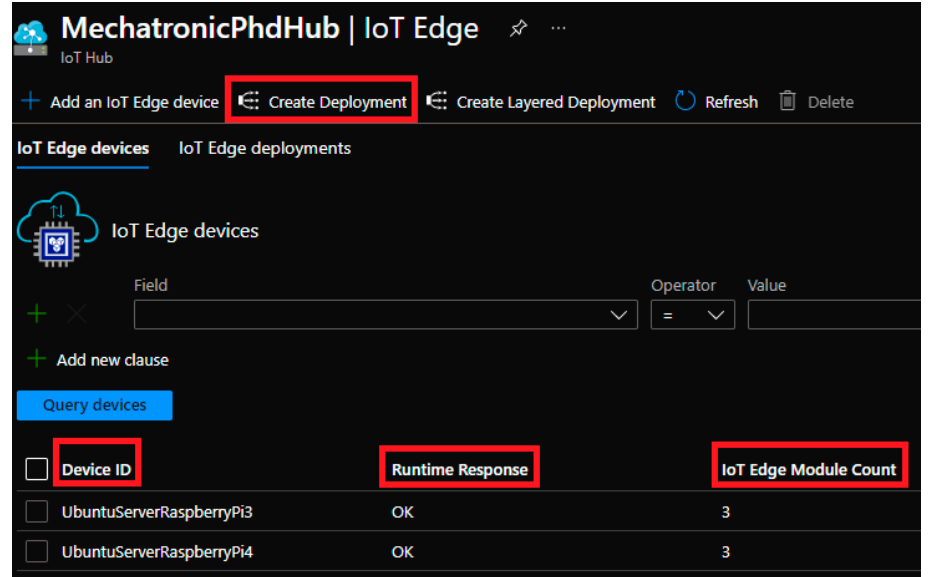
Figure 9. IoT Hub in the cloud Azure for management and deployment of IoT edge devices.